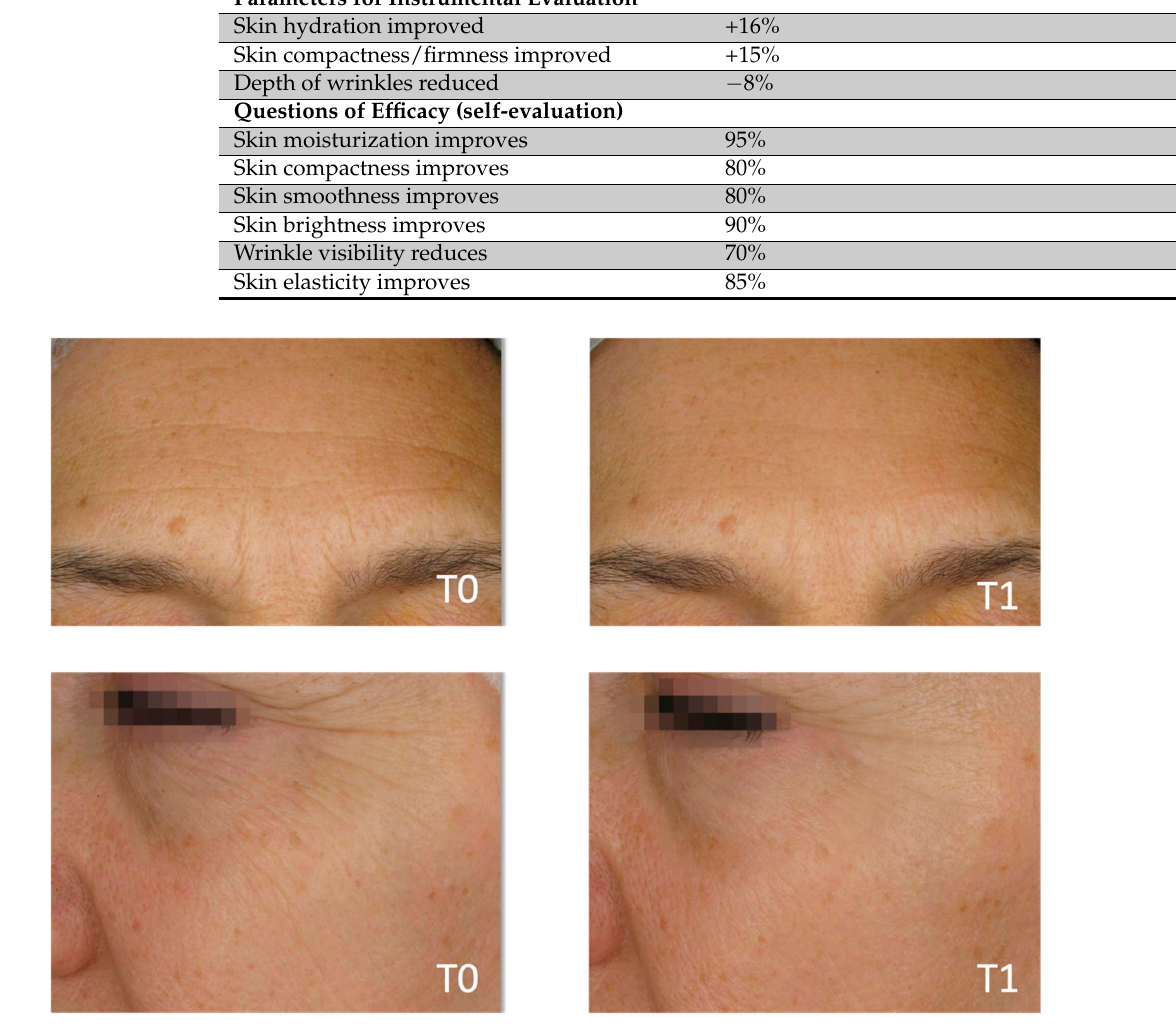
Figure 5. Application of the product visibly reduced wrinkles and dryness lines. In addition, the skin relief is improved (T0 = before treatment, T1 = after 28 days). relief is improved (T0 = before treatment, T1 = after 28